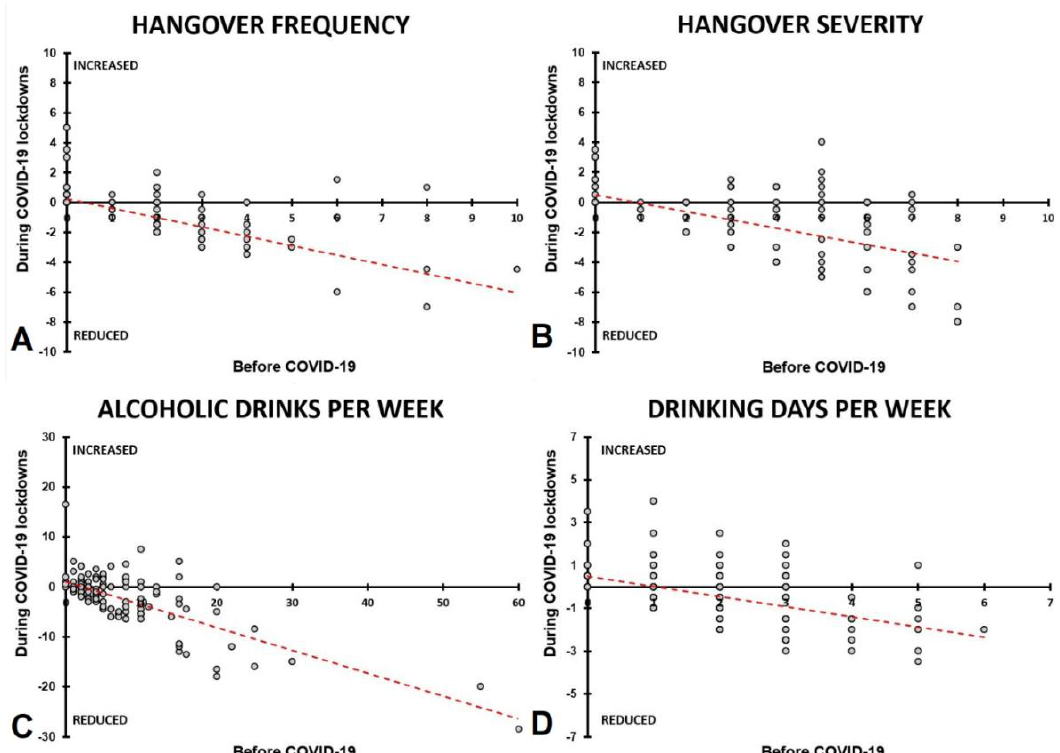
Figure 3. The effect of COVID-19 lockdowns on alcohol consumption and hangovers. Spearman’s correlations are shown between assessments made for ‘before COVID-19′ and during COVID-19 lockdowns. The change from before COVID-19 (i.e., the average score of the two lockdown periods-the ‘before COVID-19′ assessment) was correlated with the ‘before COVID-19′ assessment. Correlations are shown for hangover frequency ( A ), hangover severity ( B ), alcoholic drinks consumed per week ( C ), and the number of drinking days per week ( D ). All correlations were significant ( p < 0.001).